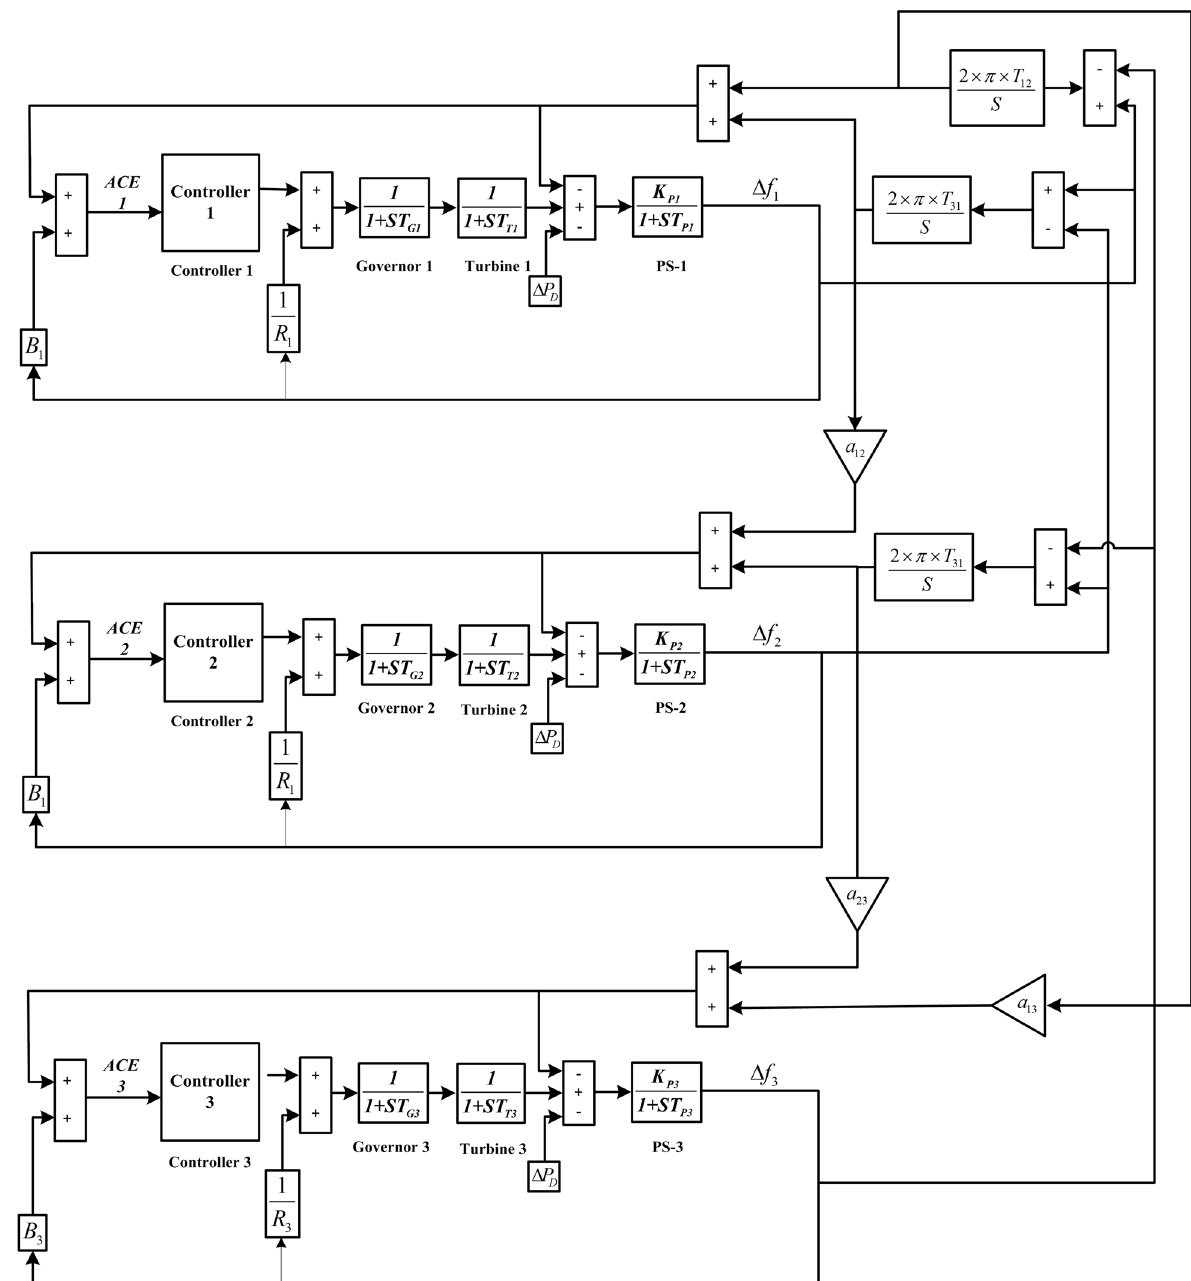
Fig. 1 Block diagram of a three-area power